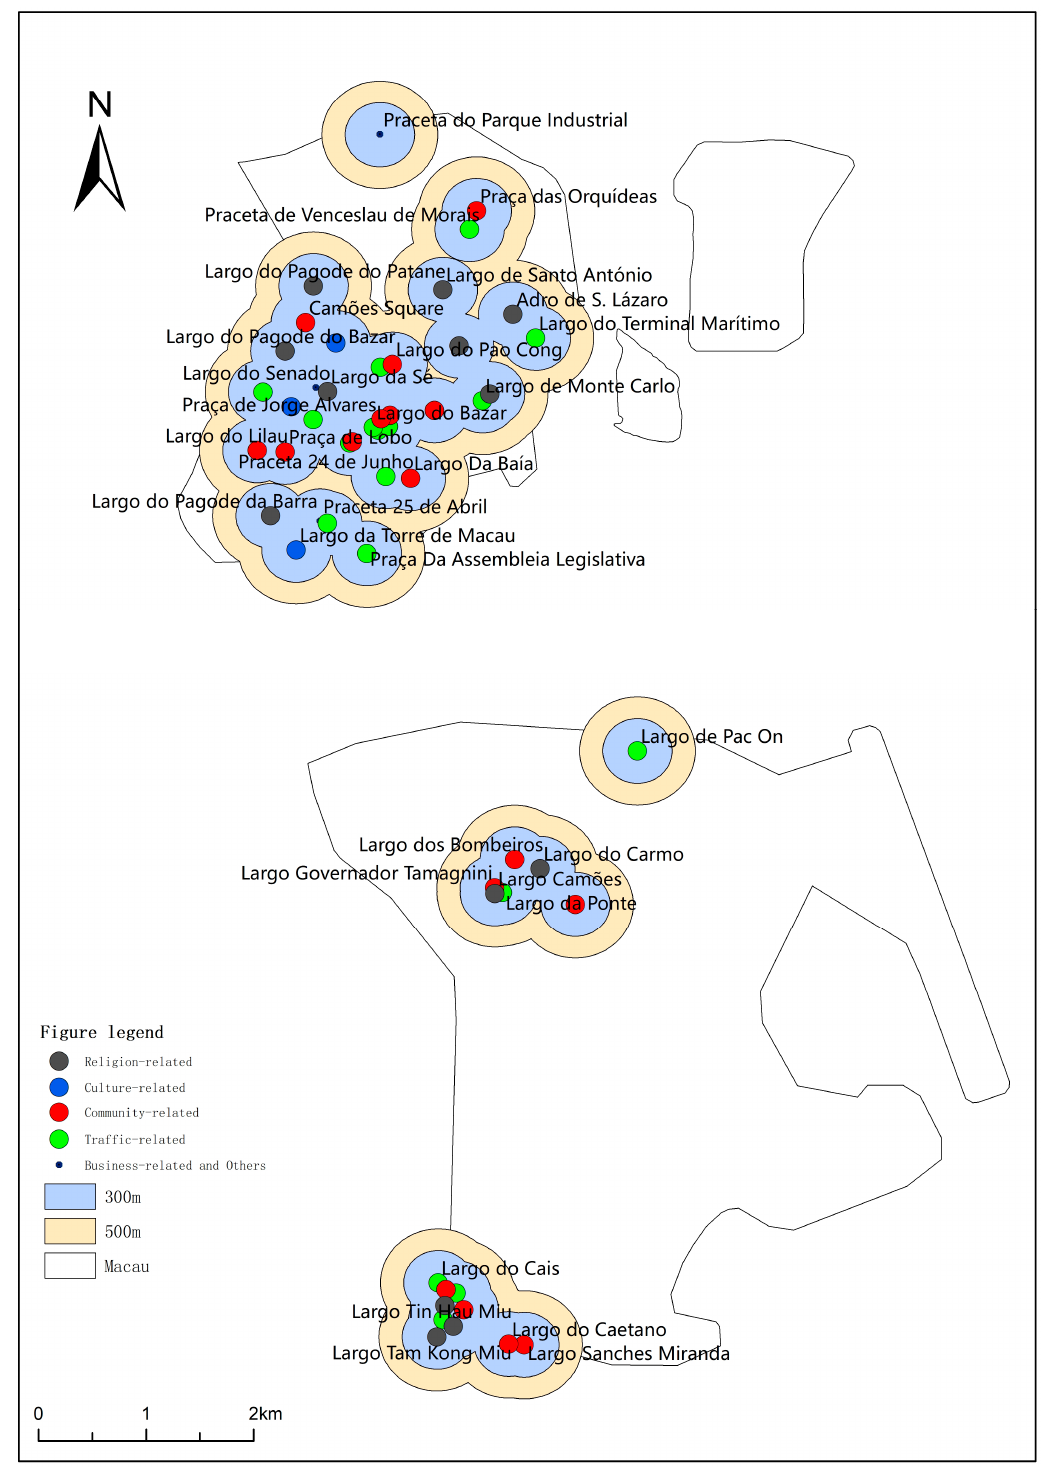
Figure 6. Buffer zone analysis.